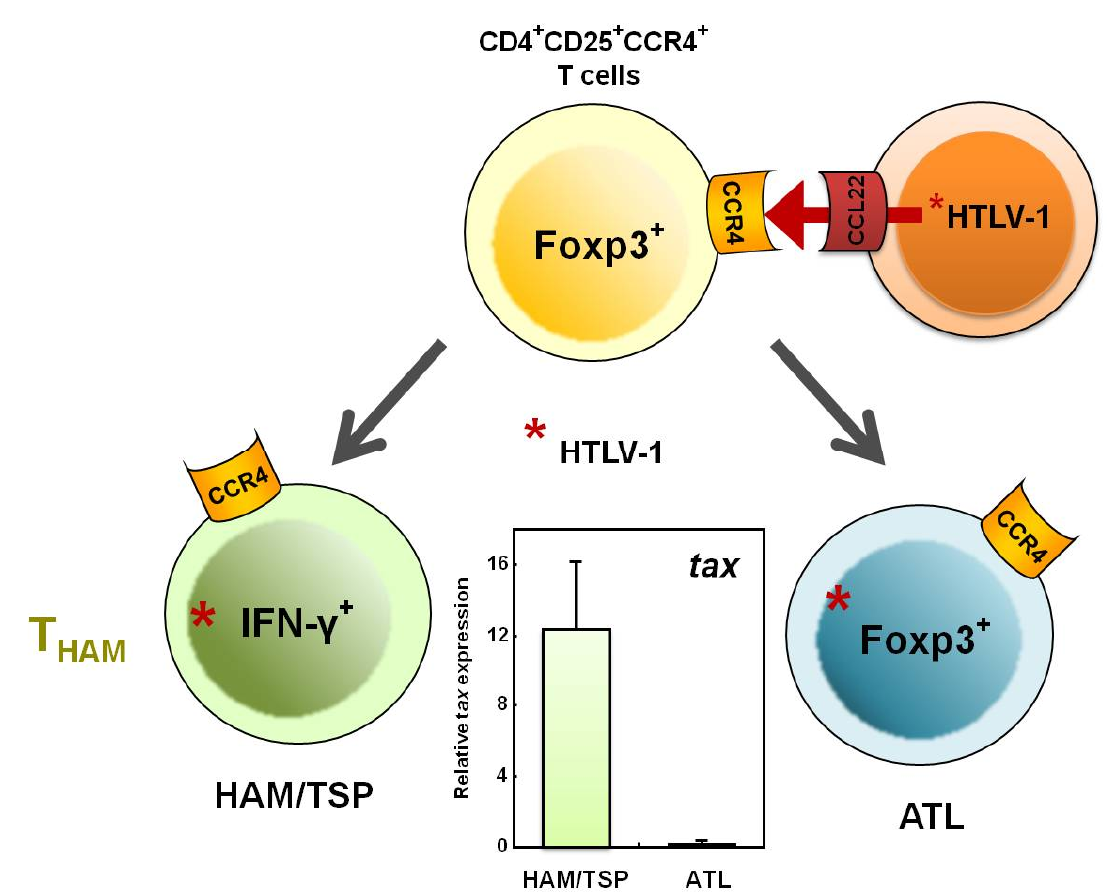
Figure 5. Differential fate of HTLV-1-infected CD4 + CD25 + CCR4 + T cells in HAM/TSP and ATL patients. After HTLV-1 infection, CD4 + CD25 + CCR4 + T cells in HAM/TSP patients, which are primarily Th2 and Treg cells before infection, become IFN- γ + Foxp3 – T cells (T cells) with high levels of intracellular HTLV-1 tax expression. In ATL patients, HAM leukemogenesis develops and the Foxp3 + Treg phenotype is